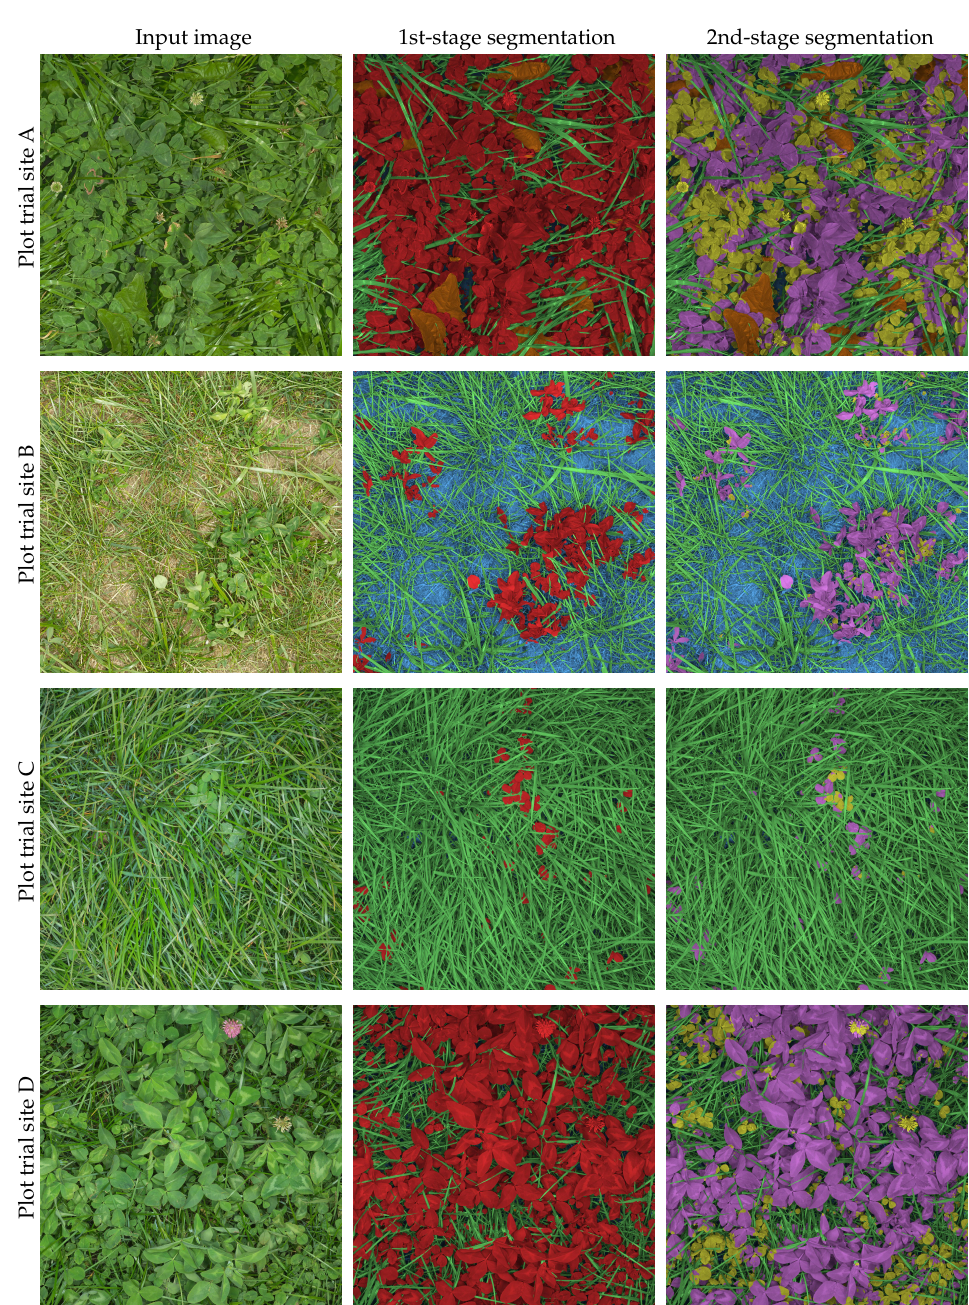
Figure 8. Qualitative samples of semantic segmentation on four plant samples of varied yield and biomass compositions using DeepLabv3+ST followed by FCN-8s for clover species discrimination. First column: Input red green blue (RGB) image of 3000 × 3000 pixels. Second column: 1st-stage pixelwise classification of image into soil (blue), clover (red), grass (green) and weeds (orange). Third column: 2nd-stage pixelwise classification of image into soil (blue), red clover (purple), white clover (yellow), grass (green), and weeds (orange).